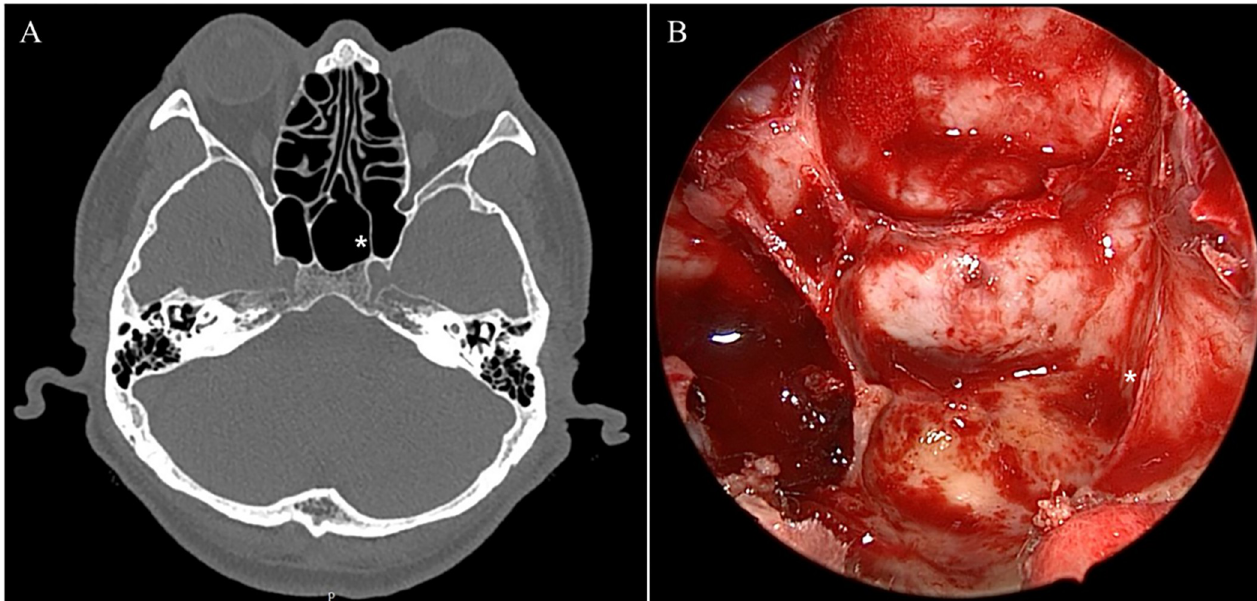
Fig 3. An intersphenoid sinus septum inserted into the paraclival internal carotid artery (asterisk) in a patient with presellar pneumatization, as revealed by paranasal sinus computed tomography (A) and during endoscopic endonasal transsphenoidal surgery (B).